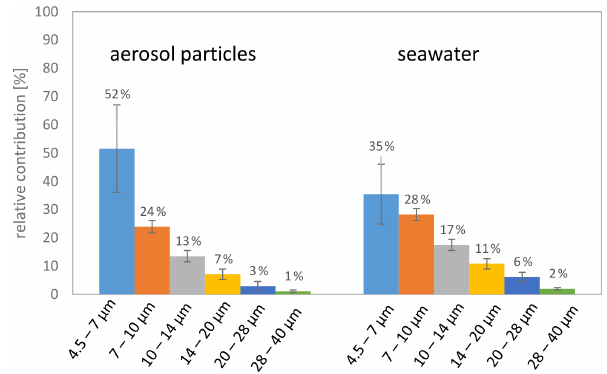
Figure 6. Relative contribution of the transparent exopolymer par- ticle number concentrations in the aerosol particles (left) and in the ocean surface water (right) regarding the identical size